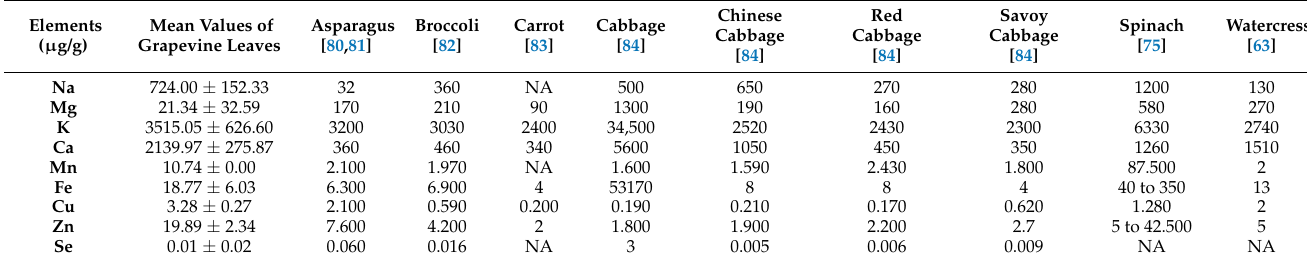
Table 5. Element composition in different plants in comparison with grapevine leaves. Elements ( µ g/g)